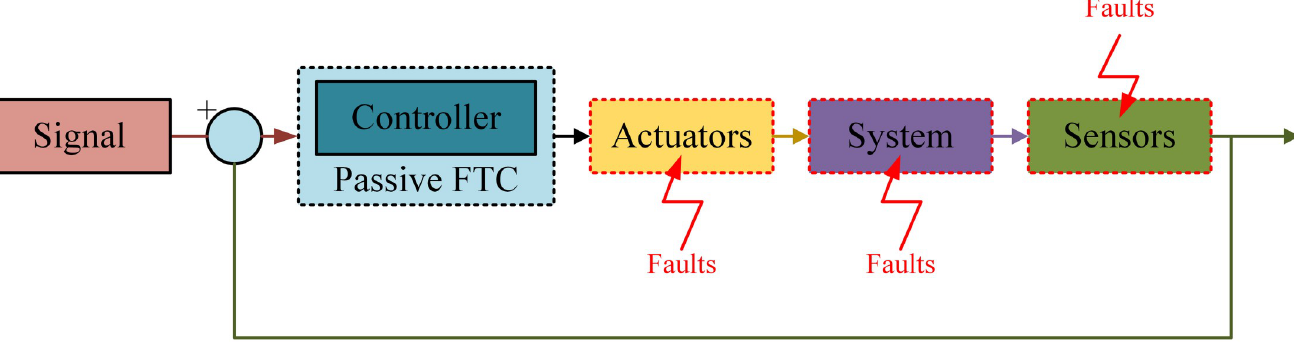
Fig 3. Passive FTC